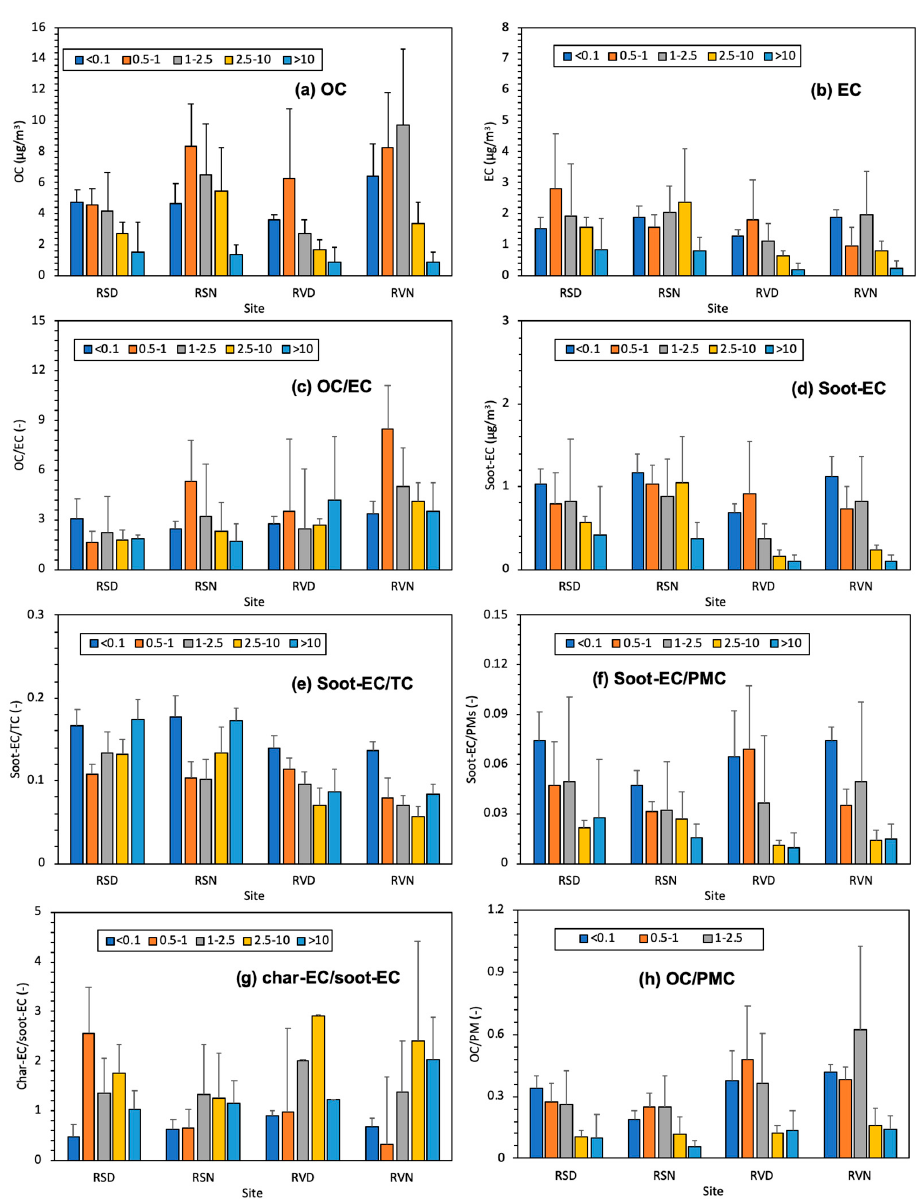
Table 2. For comparison, the values for the average mass ratio of the analyzed carbonaceous components to TC are shown in Figure 5. The EC and soot-EC, parameters which are largely related to HV vehicle emissions, were not as sensitive as the PM concentrations. However, the difference with respect to location was consistent with the expected amount of traffic. The values for these parameters, as well as other HV-related parameters such as soot-EC/TC and soot-EC/PMC, were larger or peaked mostly with respect to the PM 0.1 fraction, regardless of the location or the time of collection. This suggests that HV emissions largely account for the PM 0.1 fraction at the RS site, where the largest EC3 fraction appeared also at PM 0.1 (see Figure 5). Larger EC and soot-EC for fractions >10 µ m at the RS site compared to those at the RV site are reasonable, since a larger amount of traffic would be expected. A similar level of soot-EC/TC at the RS site may be partially attributed to tire wear that shares, e.g., 3% of the PM 10 [55–59].